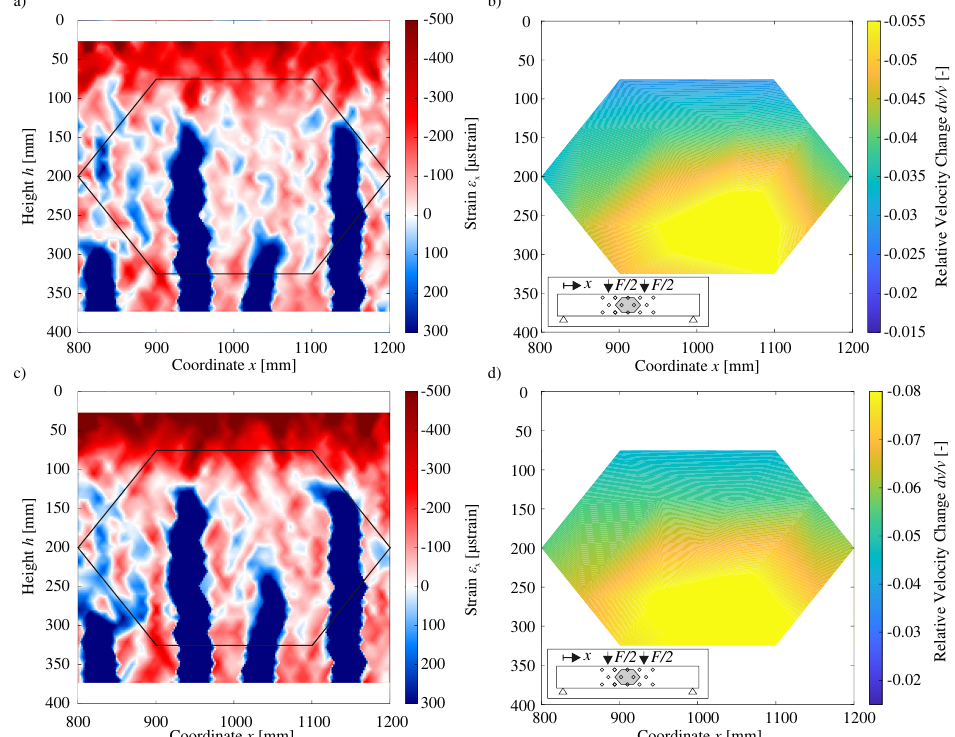
Figure 10. ( a , c ) Strain fields from DIC, ( b , d ) Relative Velocity Changes dv / v presented as